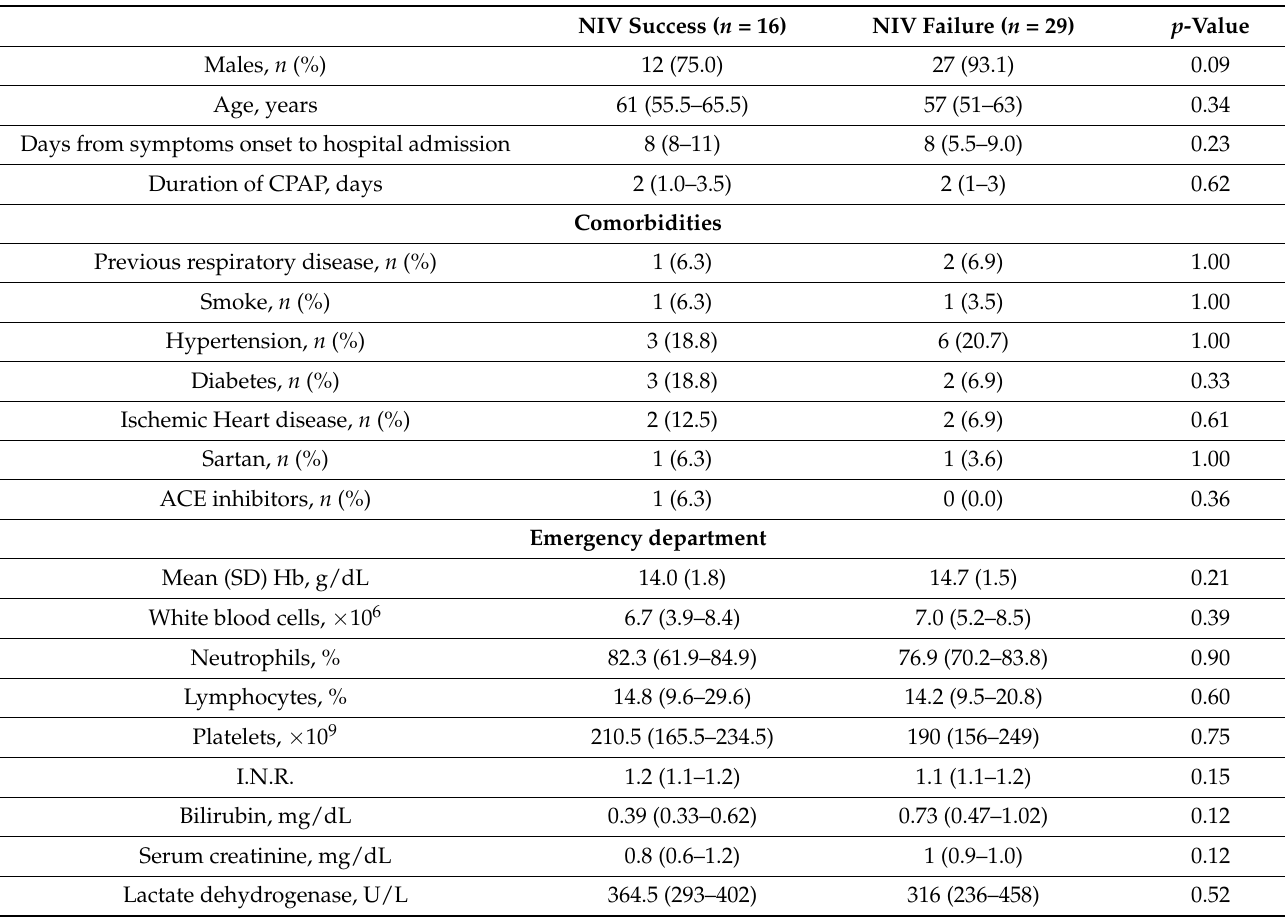
Table 3. Clinical characteristics and outcomes of patients that failed CPAP + NIV treatment and were intubated vs. patients that succeed CPAP + NIV at time of hospital admission and at the time of